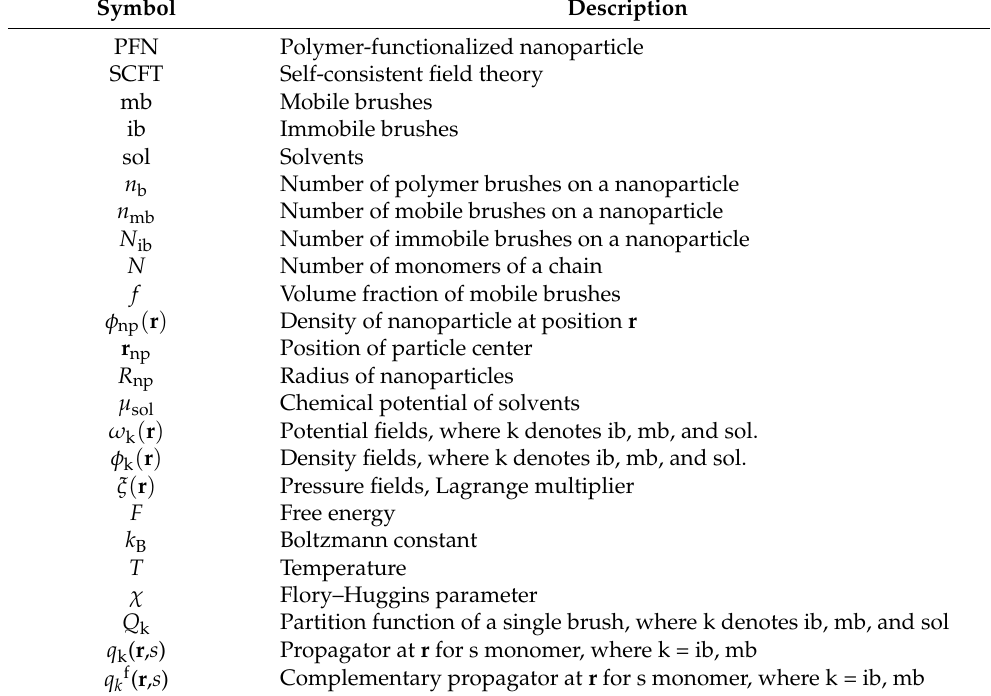
Table 1. Nomenclature in the